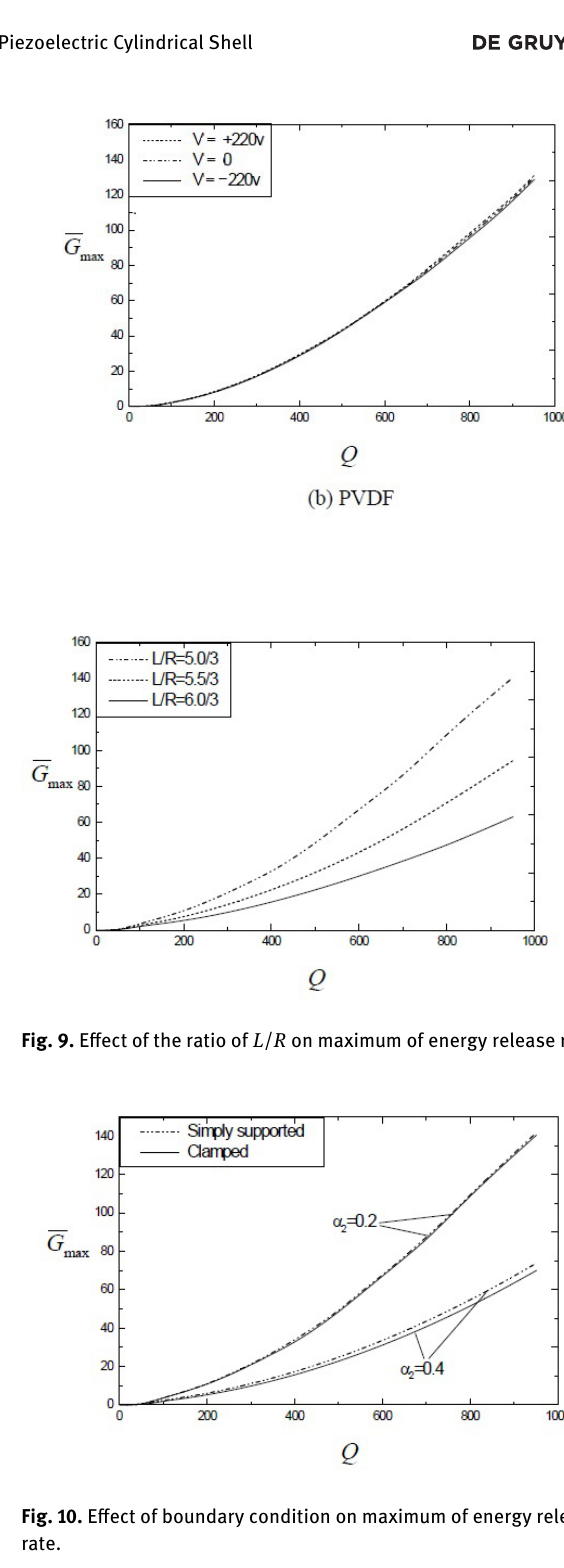
Fig. 8. Effect of delamination depth on maximum of energy release rate.